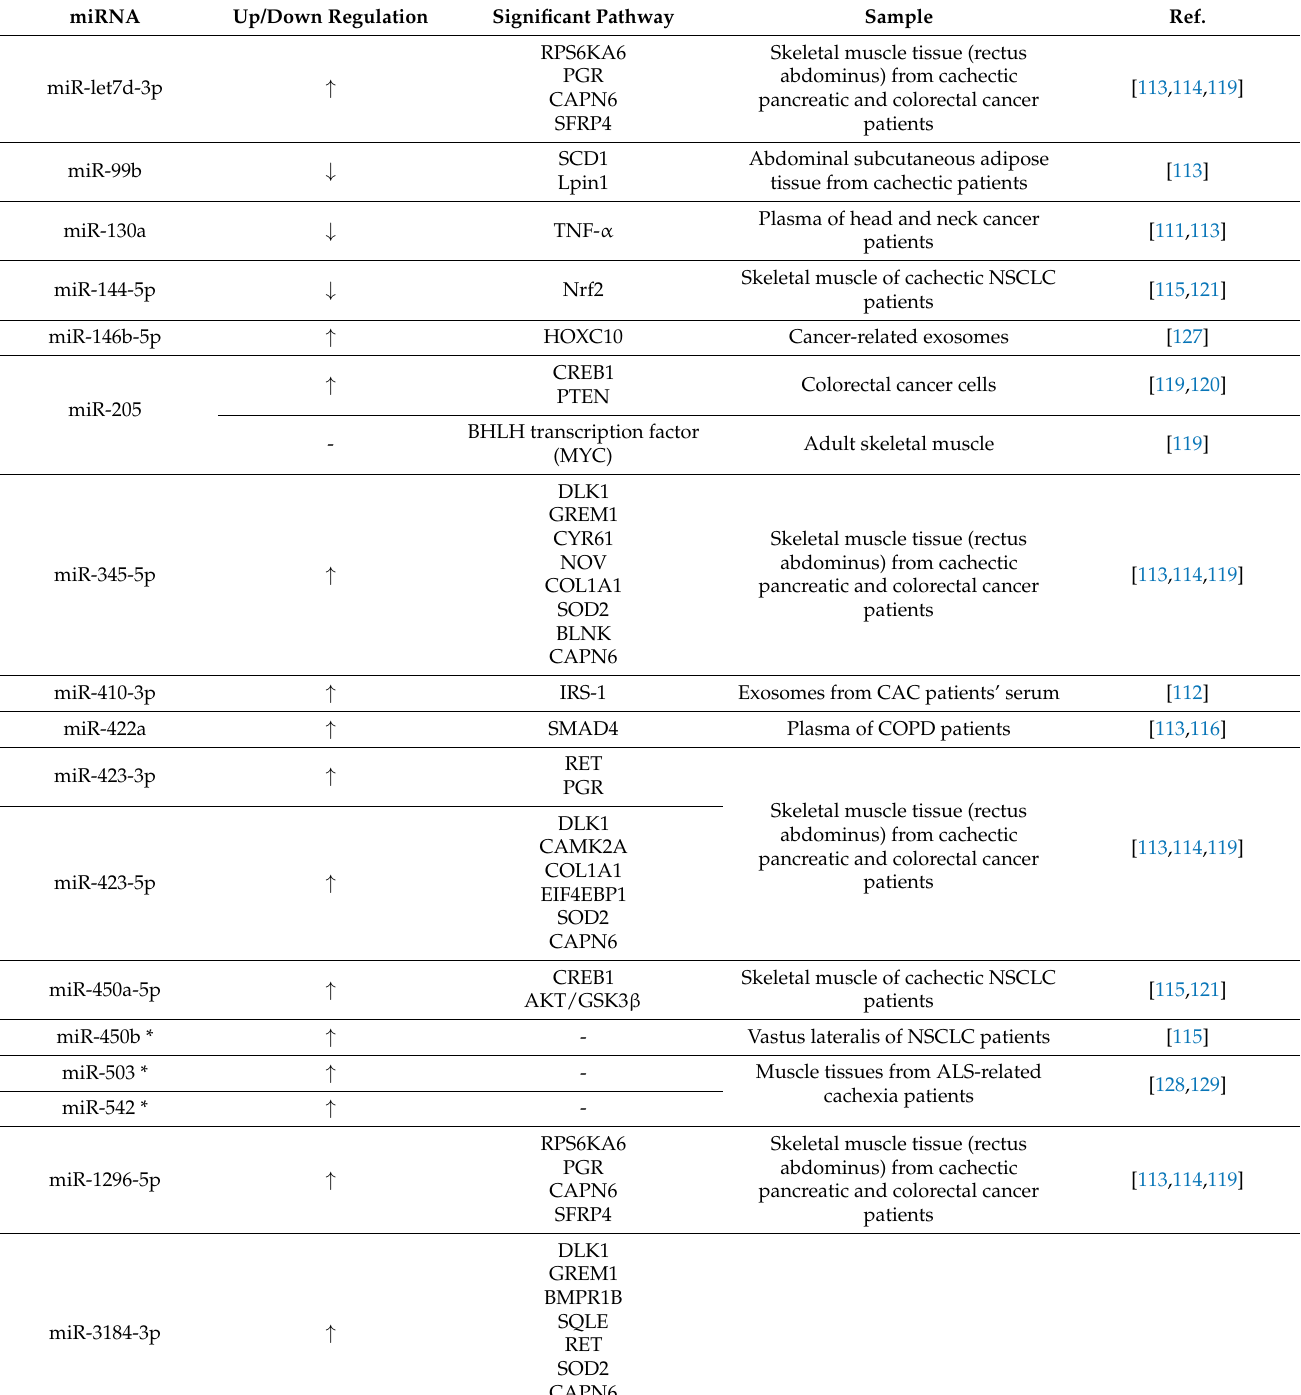
Table 1. Cachexia—Exclusive miRNAs dysregulated in cachectic